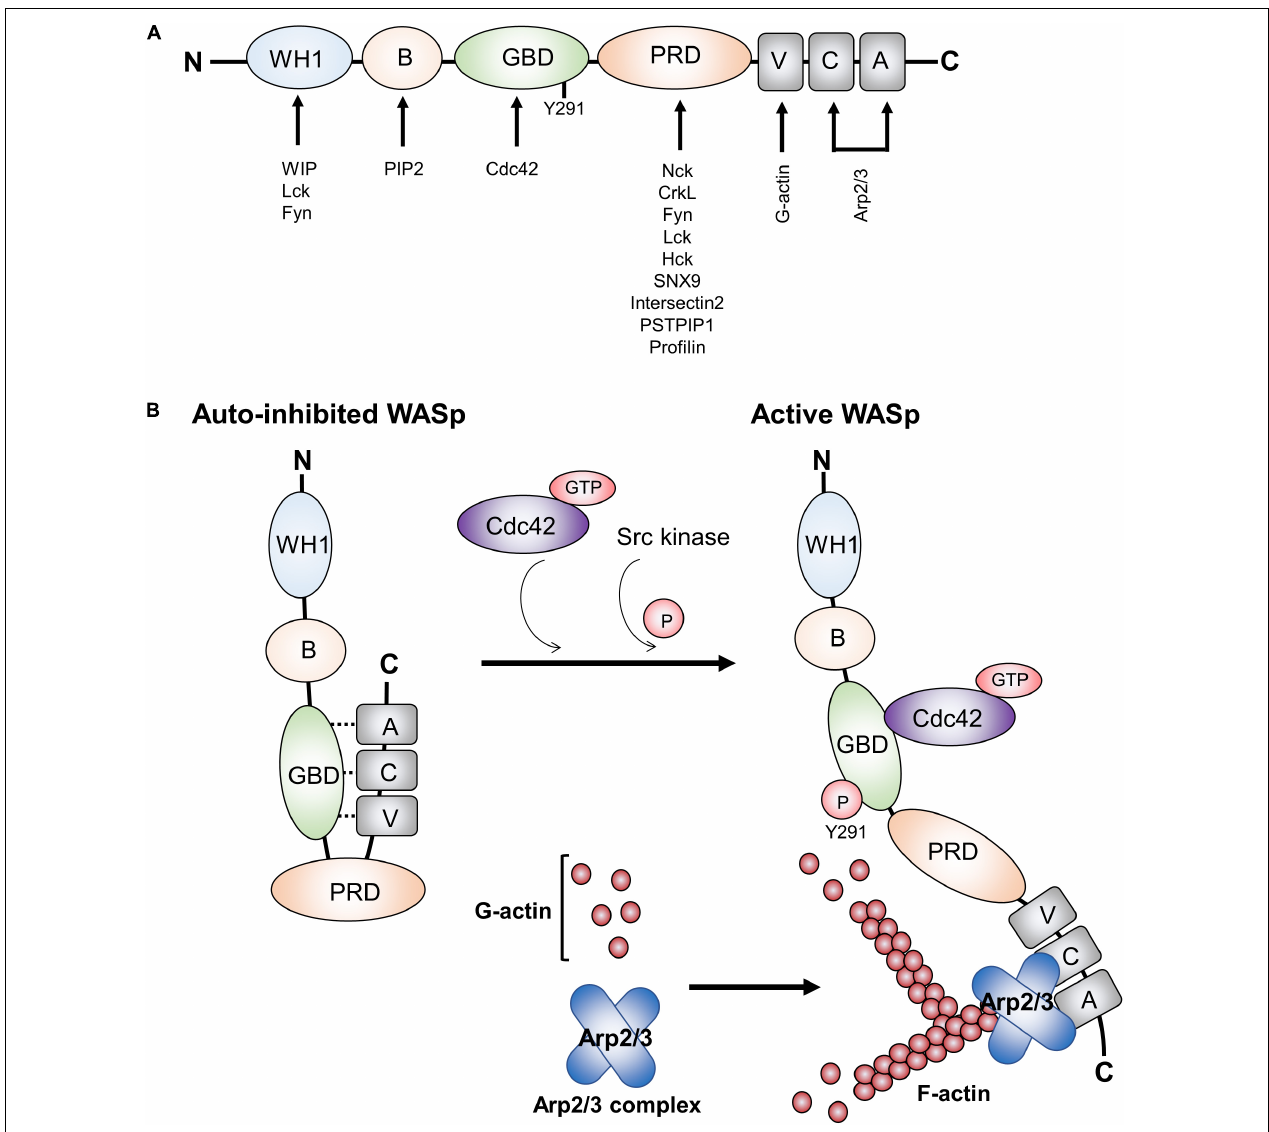
FIGURE 1 | Functional domains in WASp and WASp activation. (A) WASp contains various domains, which can bind proteins involved in TCR-mediated actin cytoskeleton remodeling and signal transduction. (B) WASp is in a closed auto-inhibited conformation in resting state due to its intracellular interaction between GBD and VCA domains. Upon TCR engagement, it mediates the binding of GTP-Cdc42 to the GBD domain, thereby releasing the VCA domain from GBD domain and changing the WASp structure into an opened conformation. In addition, WASp tyrosine 291 within GBD can be phosphorylated by the Src family kinases Fyn and Lck. Recruitment of GTP-Cdc42 to GBD and phosphorylation of WASp tyrosine 291 within GBD result in WASp activation. Subsequently, Arp2/3 and monomeric actin can bind the VCA domain, which induces a new actin branch. This figure was modified from Matalon et al. (2013). Wiskott-Aldrich syndrome protein–dynamic regulation of actin homeostasis: from activation through function and signal termination in T lymphocytes. Immunol. Rev. 256(1), 10–29; with a permission from John Wiley and Sons; license number 5065241058992.